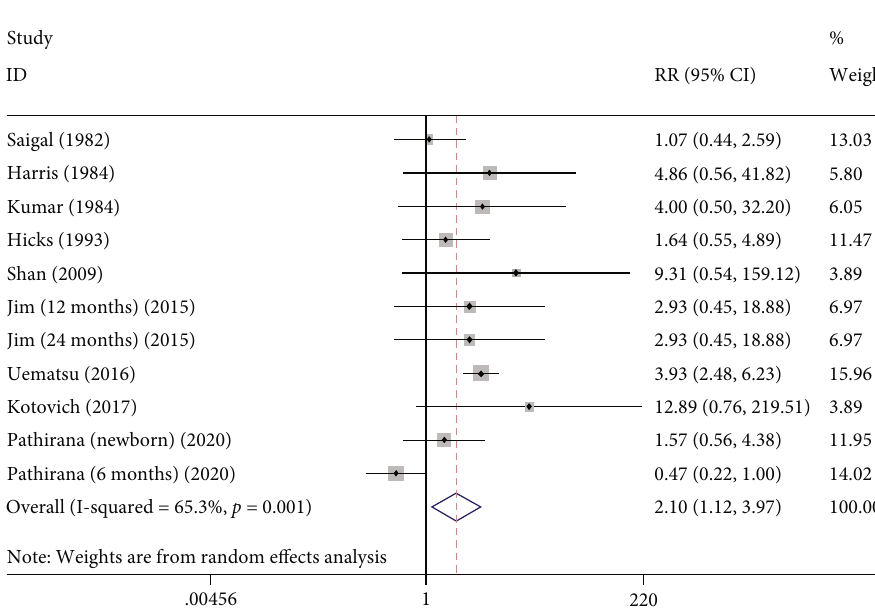
Figure 2: The forest plots of hearing impairment between CMV group and control